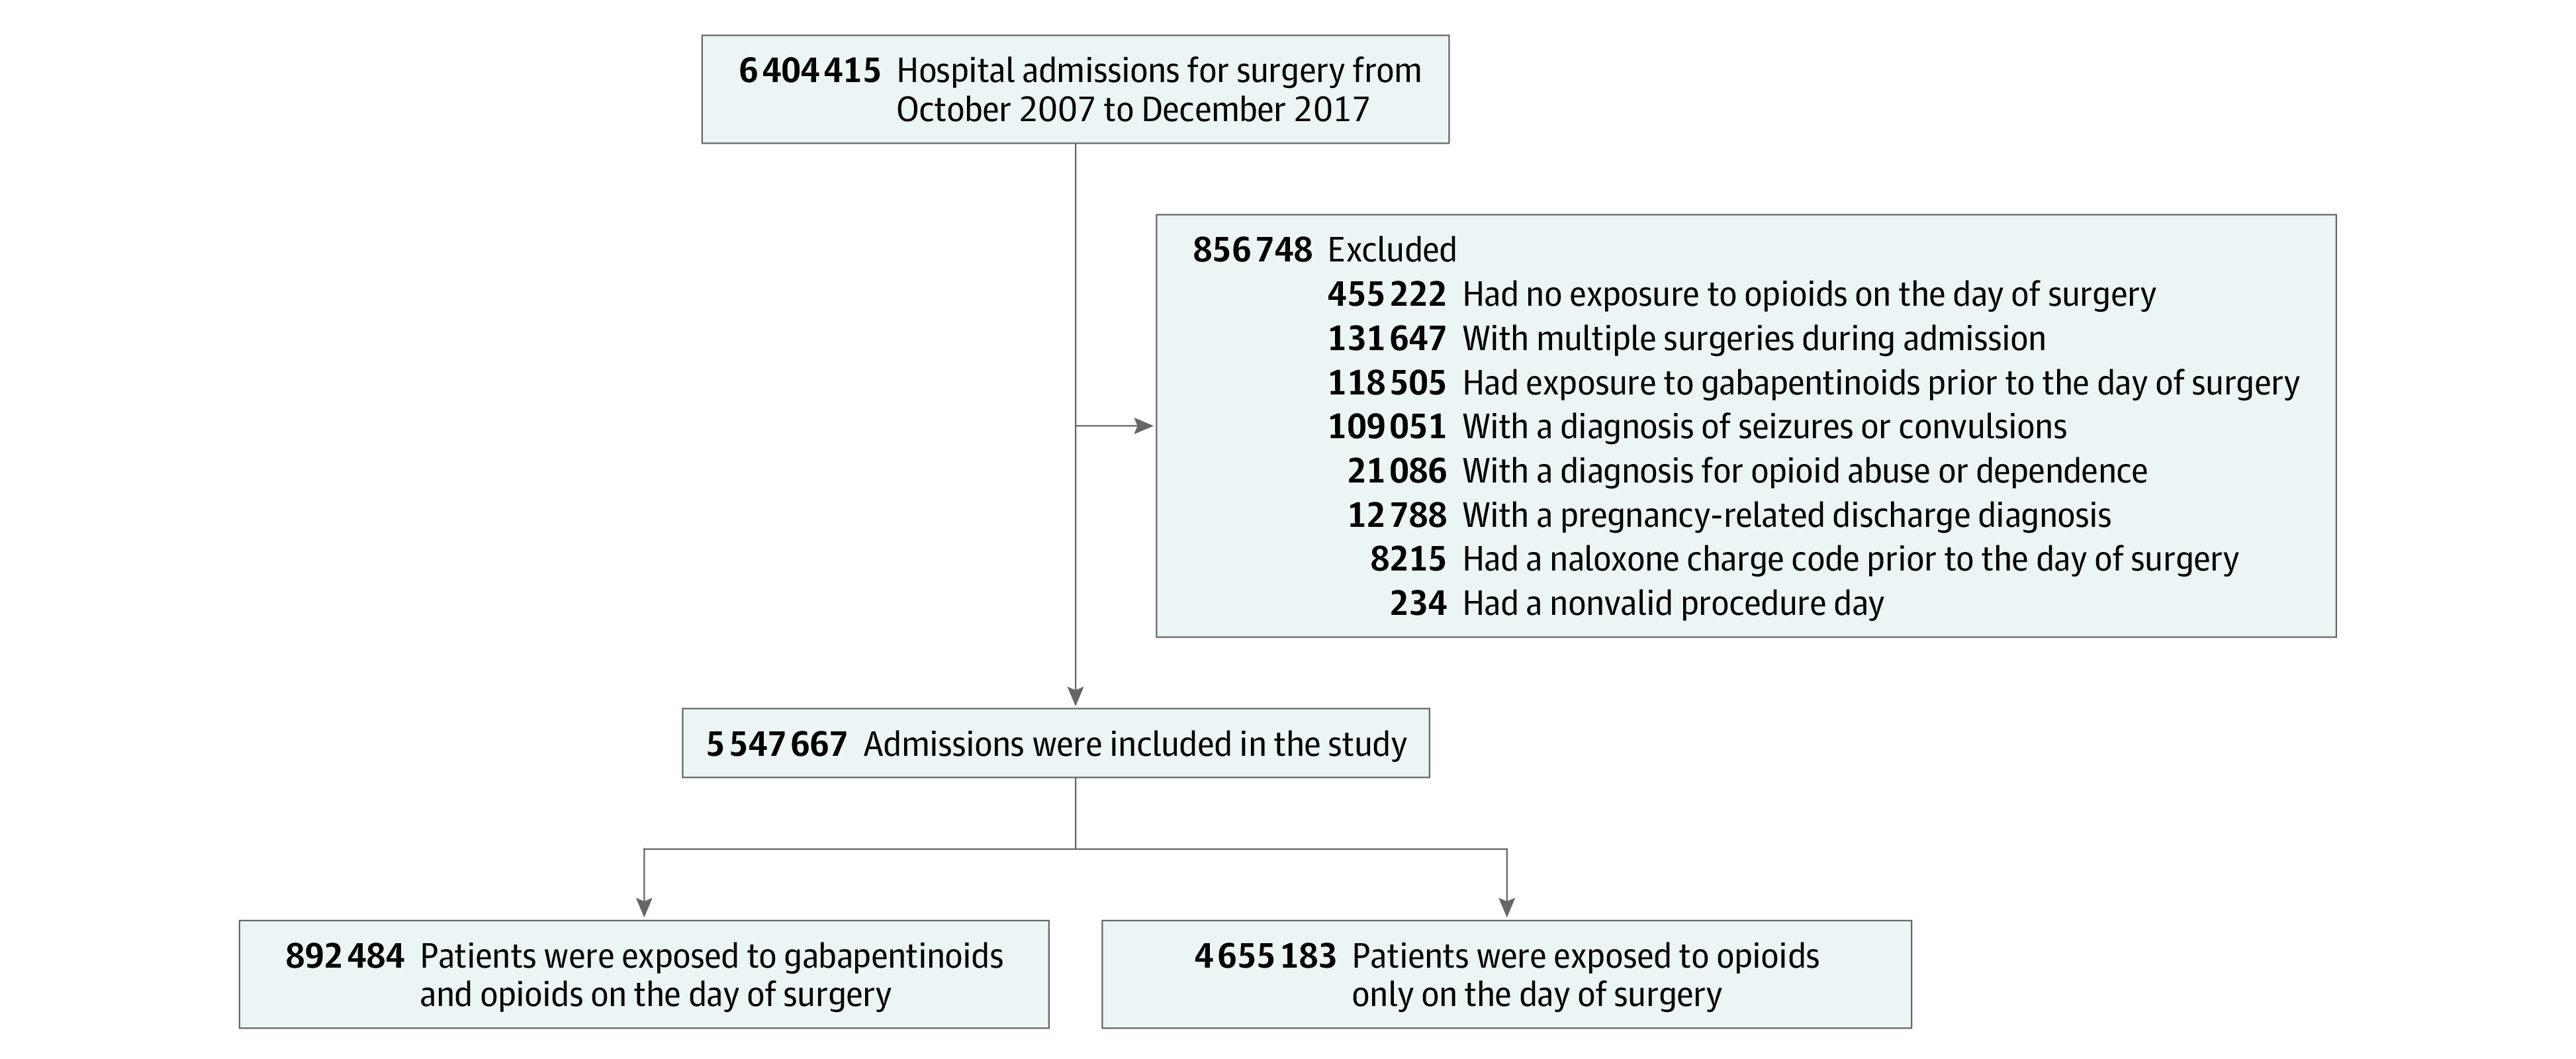
Study CohortExposure to medications was measured by medication charge codes.